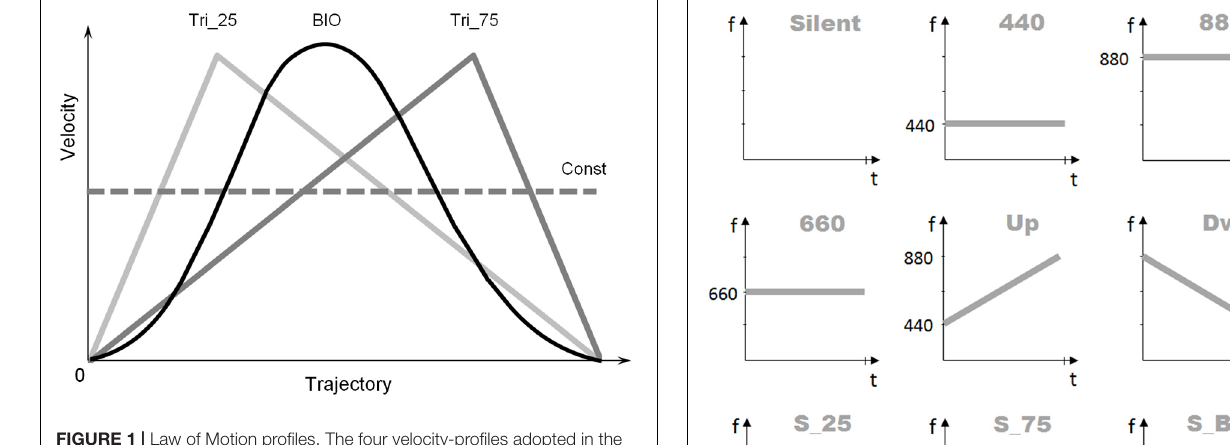
FIGURE 1 | Law of Motion profiles. The four velocity-profiles adopted in the three experiments: one “Biological” velocity profile (“BIO,” black line), two “Triangular” profiles (“Tri_25” and “Tri_75,” gray lines) and one Constant profile (“Const,” dotted line). The biological velocity profile was obtained as the average of several arm-pointing movements, upward oriented and performed with a straight arm, previously recorded in frontal view. The two triangular velocity profiles are characterized by linear acceleration and deceleration; they differ in the position of the peak of velocity: at 25% of the trajectory for the Tri_25, and 75% of the trajectory for the Tri_75. The Const velocity profile consisted of a constant-velocity movement over the whole trajectory. The four profiles are characterized by the same average velocity. The four different durations of the motion (0.5, 1.0, 1.5, or 3.0 s) correspond to the four average velocities: 30, 15, 10, or 5 [degrees/second] for participants.